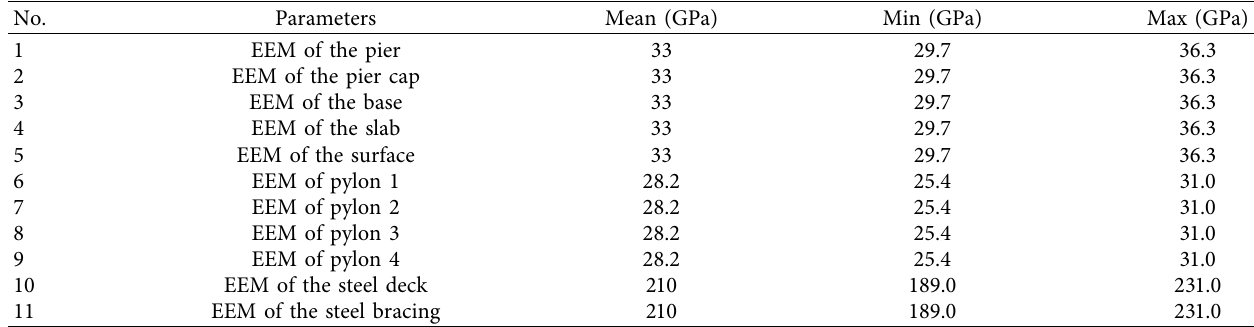
Table 8: The selected parameters and their lower and upper